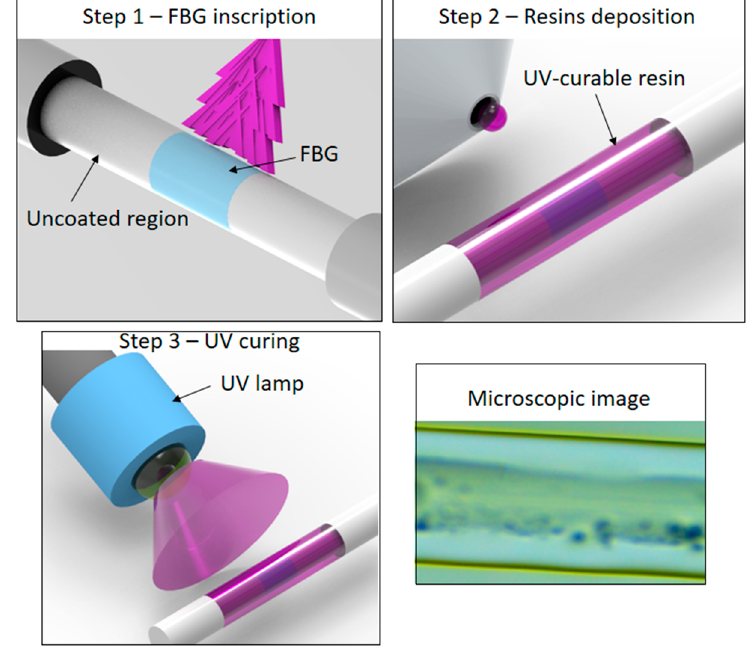
Figure 1. Schematic representation and microscopic image of the UV-curable resins coating on the fiber Bragg grating (FBG) .